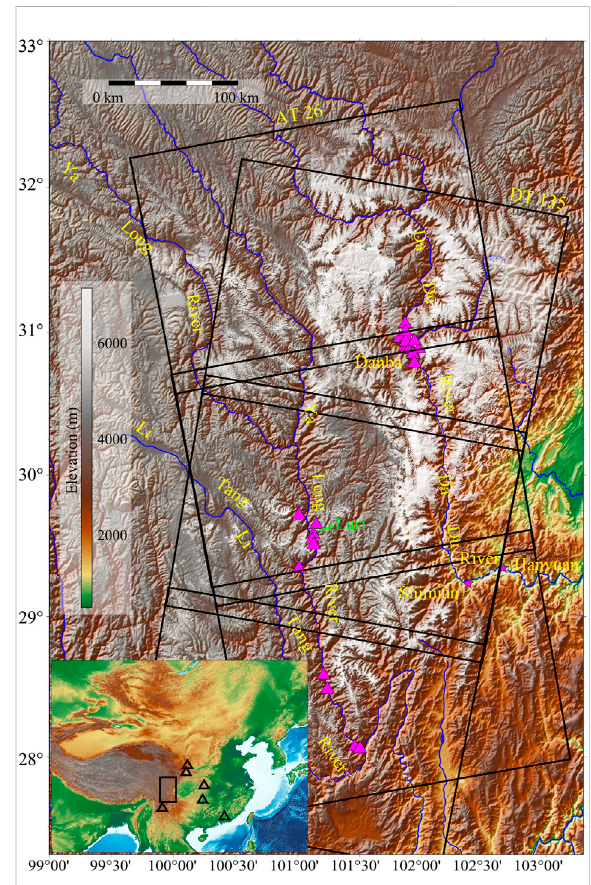
FIGURE 1 Study area and data coverage. Blue lines indicate the Litang, Yalong and Dadu rivers. Black boxes indicate Sentinel-1 data coverage by Ascending Track (AT) 26 and Descending Track (DT) 135(bothwiththreeframes).Themagentatrianglesrepresent locations of studied landslides from previous time-series InSAR analysis (Dong et al., 2018; Dai et al., 2020). The snow-covered areas are colored white. The black boxes and triangles in the left- down inset map display locations of the study area (ROI) and other regions for collecting training samples for our deep-learning network. These areas are prone to slow-moving landslides in China and provide abundant and diverse training samples for training the deep-learning model. These regions are as mountainous as the study area but some have denser vegetation (southeastoftheROI),somehaveaclay-loesslandform(northeast of the ROI) and some have steep reliefs (southwest of the